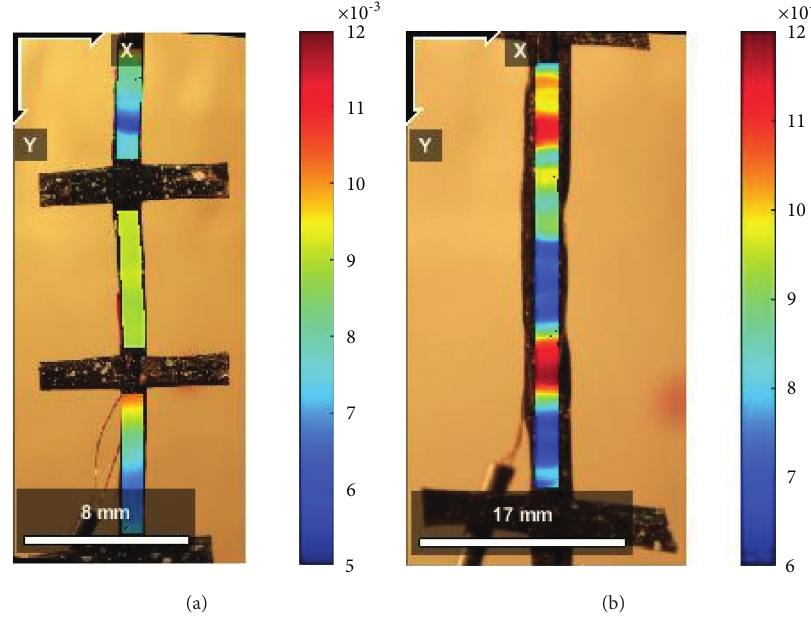
Figure 11: Vertical strain result of V-CFRP grids at their ultimate load. (a) H-CFRP-1. (b) H-CFRP-2.